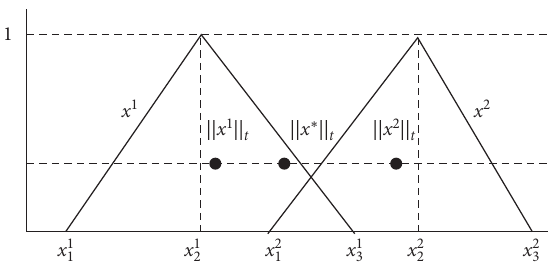
Figure 1: Geometric representation of TFNs and their